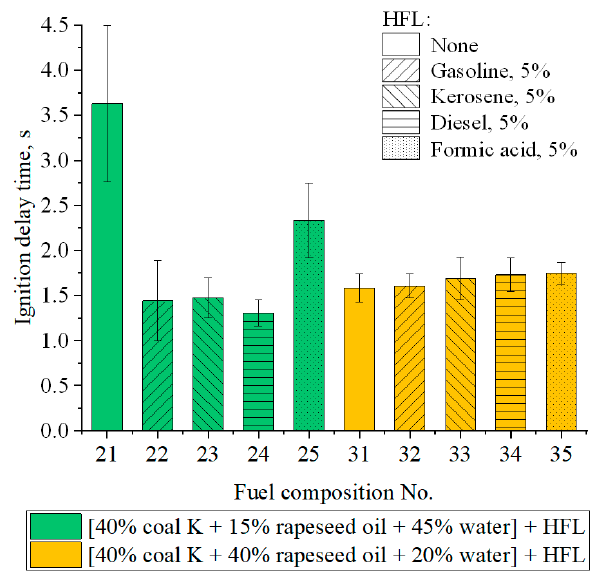
Figure 8. Ignition delay times of composite fuel droplets with different HFL additives.